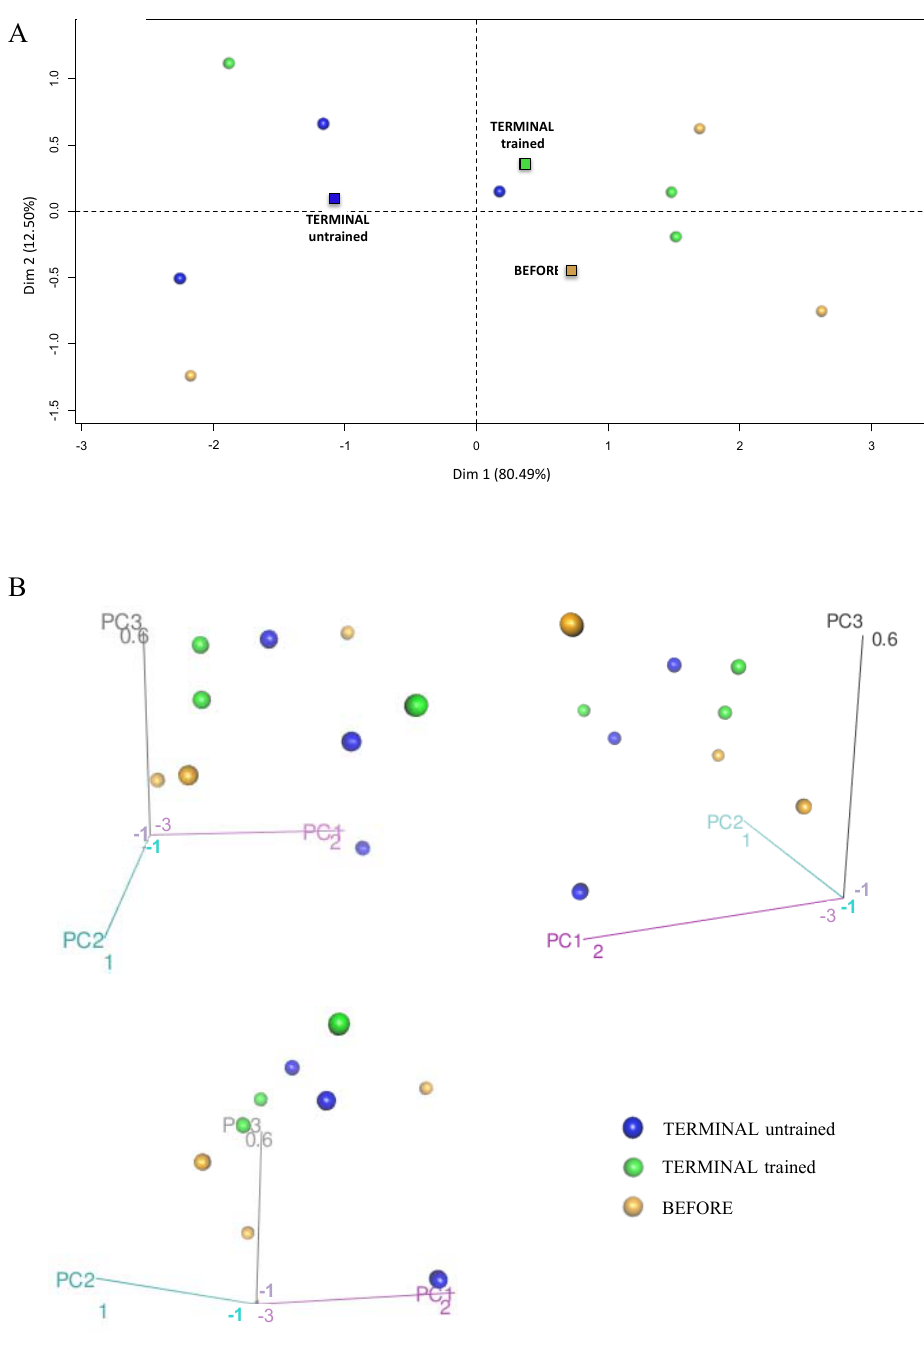
Figure 6. Principal component analysis presenting the profile of NADH shuttle enzymes (cASPAT, mASPAT, cMDH, and mMDH) in the skeletal muscle of the BEFORE, TERMINAL untrained, and TERMINAL trained mice: ( A ) The 2D graph of variables PC1 and PC2 created using PCA based on the level of 4 identified NADH shuttles enzymes (MAS) measured in ALS mice samples; ( B ) the 3D graphs of variables PC1, PC2, and PC3 created using PCA based on the level of 4 identified NADH shuttles enzymes (MAS) measured in ALS mice samples. 3D individual graphs show the view from a different angle on the same distribution of events in the 3D space. The data are presented as the means (squares) and individual results (dots) ( n = 3 in each group).